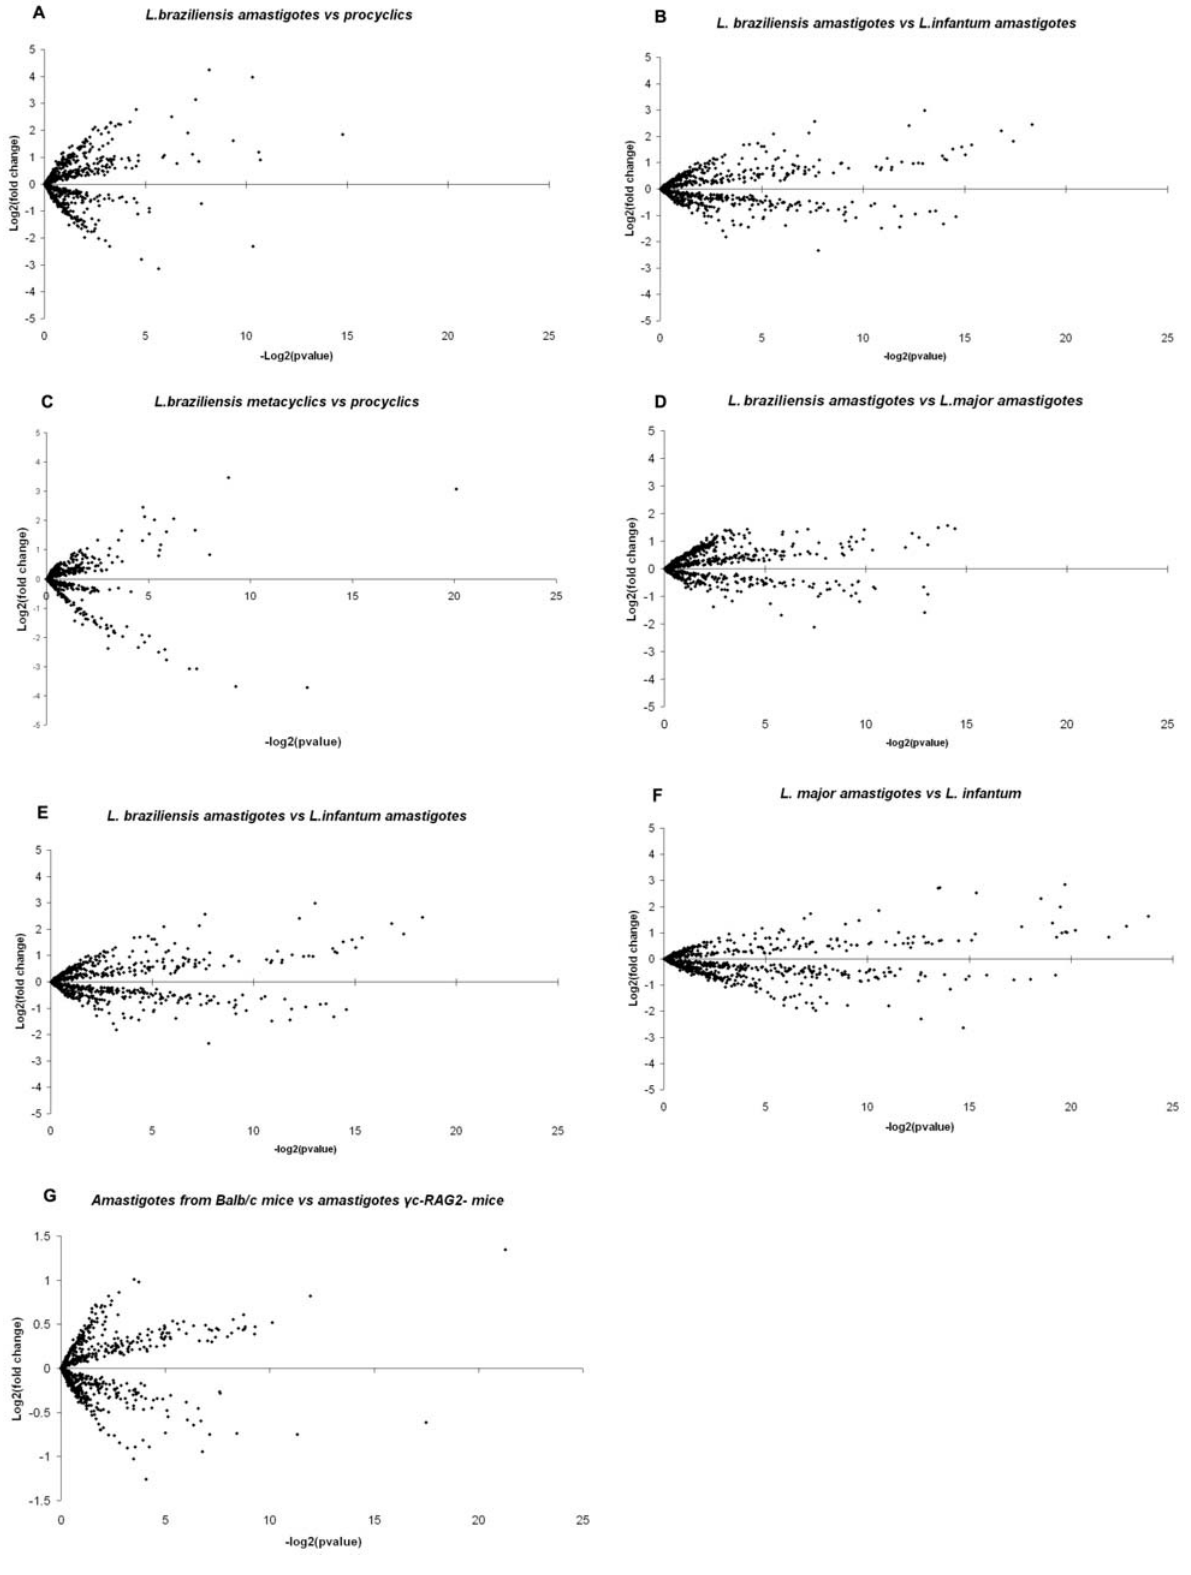
Figure 1. Expression profiling of gene subsets from three Leishmania genomes. Scatter plots (generated using Microsoft Excel) show the distribution of log 2 fold changes in RNA expression levels against their statistical significance ( 2 log 2 p-value) for up to 785 genes per genome. Fold change of . 1.7 between data points (dashed horizontal lines); significant p-value , 0.05 (dashed vertical lines). (A) L. braziliensis amastigotes vs. procyclics; (B) L. braziliensis amastigotes vs. metacyclics; (C) L. braziliensis metacyclics vs. procyclics; amastigotes of (D) L. braziliensis vs. L. major , (E) L. braziliensis vs. L. infantum , (F) L. major vs. L. infantum ; (G) L. major amastigotes from BALB/c vs. Rag2 2 / 2 c c 2 / 2 mice.